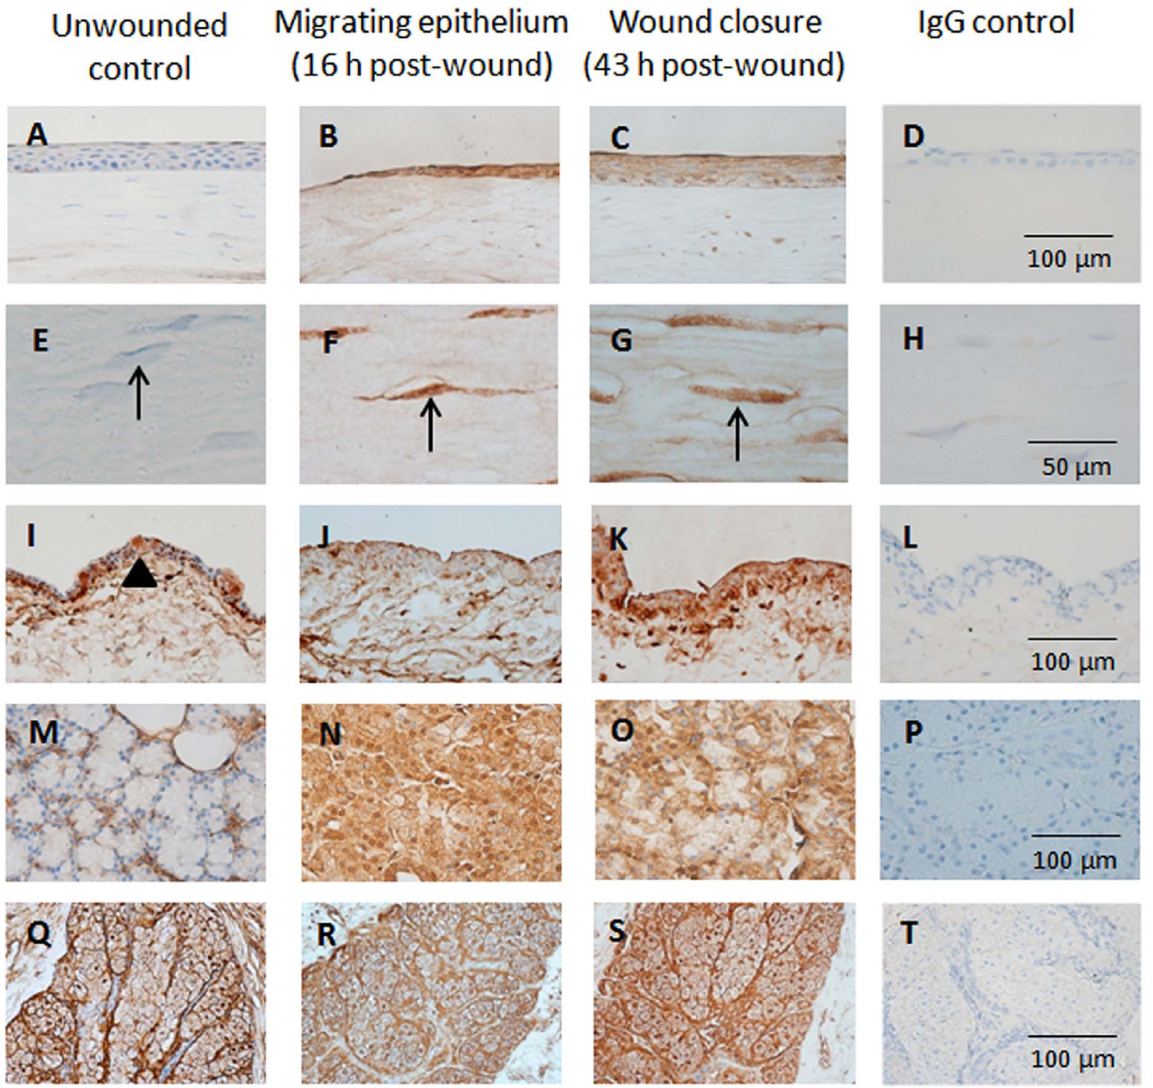
Figure 2. MMP-9 expression in ocular surface tissues. Representative light micrographs of tissue sections showing MMP-9 expression in (A–D) corneal epithelium, (E–H) stromal keratocytes, (I–L) bulbar conjunctival epithelium, (M–P) lacrimal gland and (Q–T) meibomian gland of unwounded control eyes collected prior to surgery, and wounded eyes at various stages of healing. Arrows indicate stromal keratocytes. Arrow head shows an example of a conjunctival goblet cell.